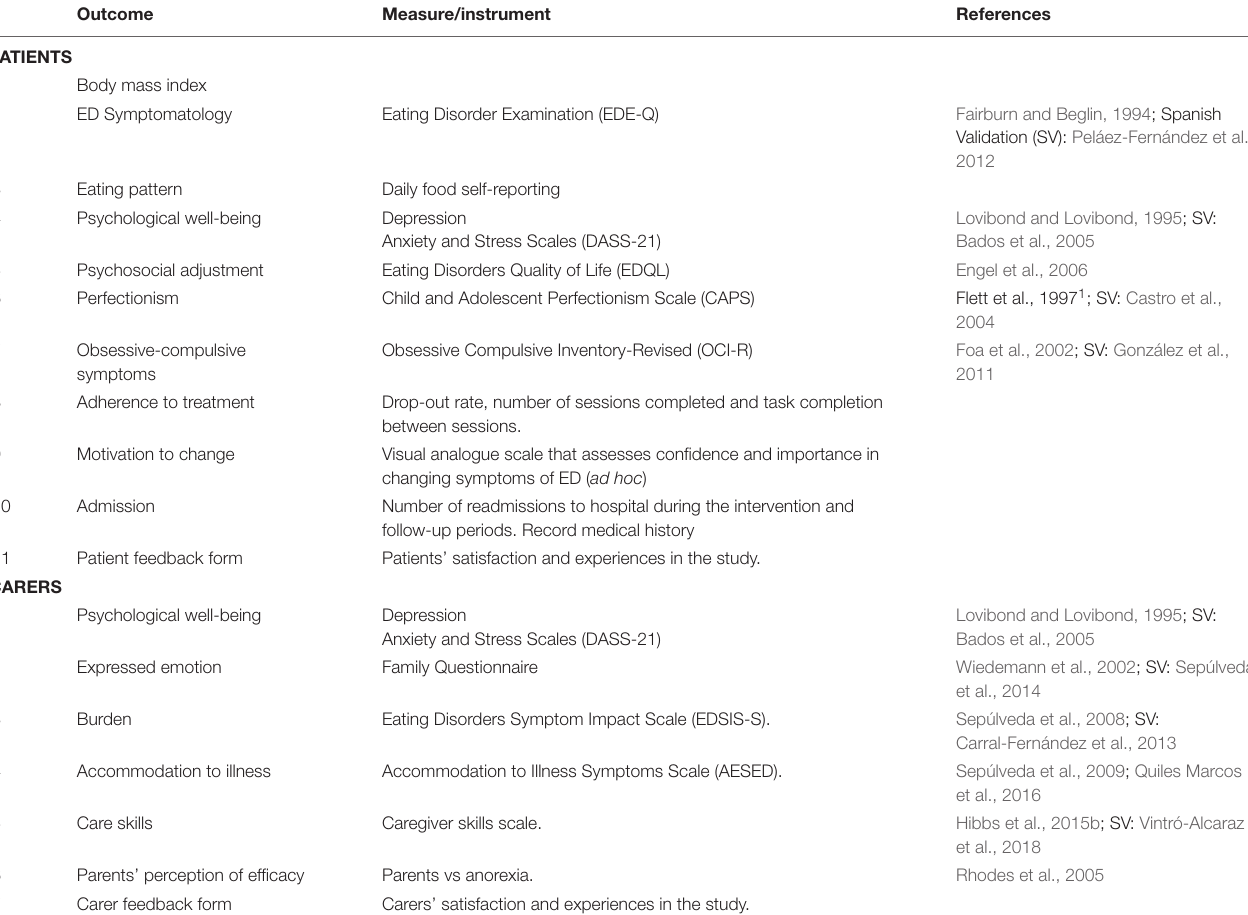
TABLE 1 | Outcomes and